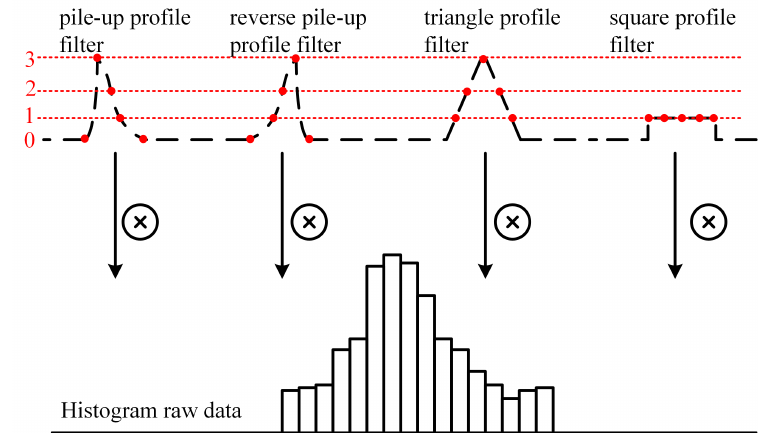
Figure 5. The processing of the different types of matched filters.